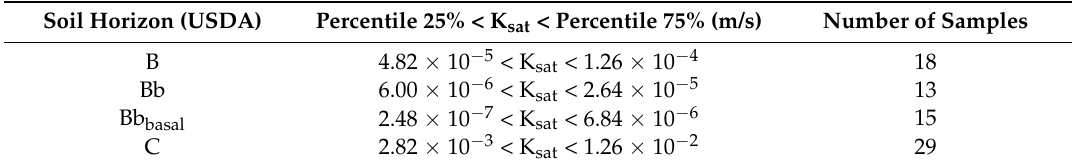
Table 3. Range of saturated hydraulic conductivity (K sat ) between percentiles of 25% and 75% determined for each ash-fall pyroclastic soil horizon